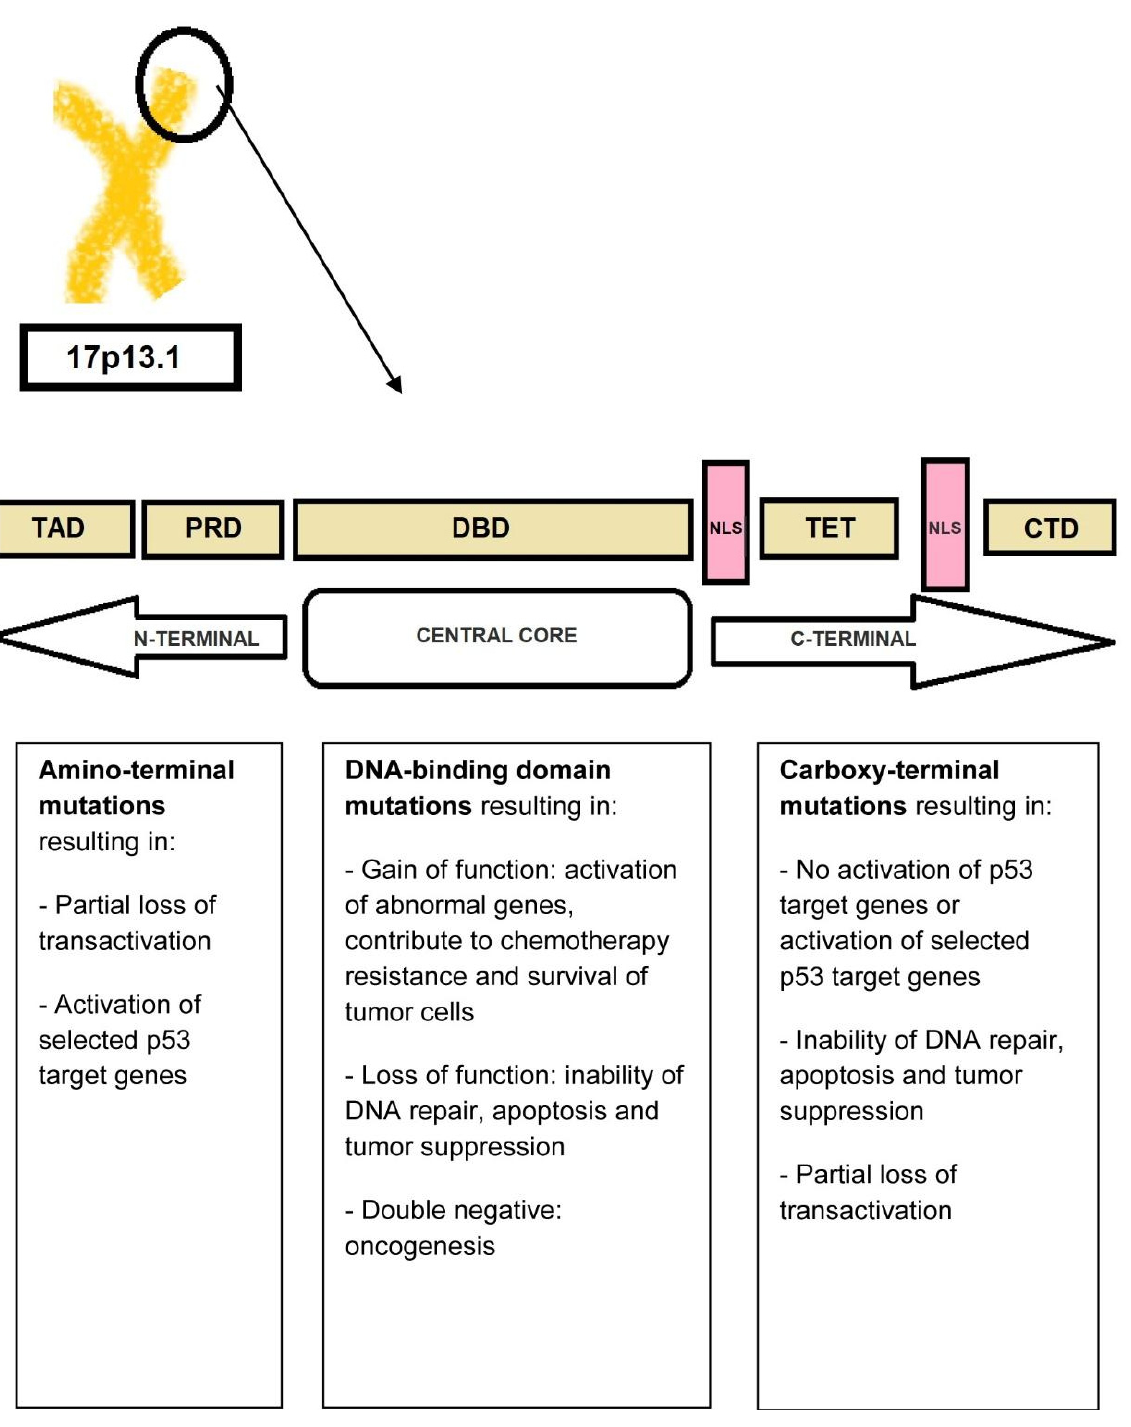
Figure 3. P53 protein structure. The N-terminal portion of the p53 protein includes the transactivation domains (TAD) I and II and the proline-rich domain (PRD). The central core of the protein includes the DNA-binding domain (DBD). The C-terminal portion of p53 includes the tetramerization domain (TET) required for p53 tetramerization and activation, several nuclear localization sequences (NLS), and the carboxy-terminal regulatory domain.